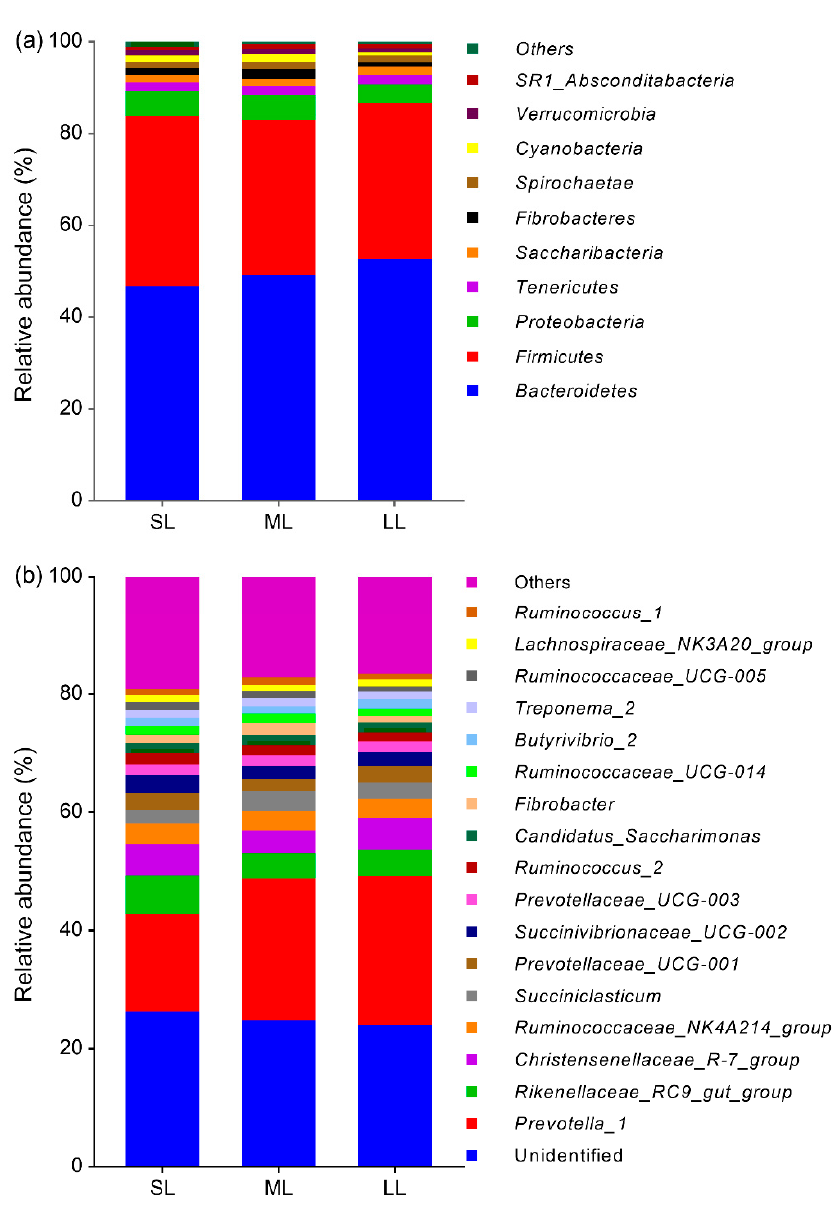
Figure 1. Effects of roughage length on ruminal bacteria at phyla ( a ) and genus ( b ) levels. SL: short length; ML: medium length; LL: long length.